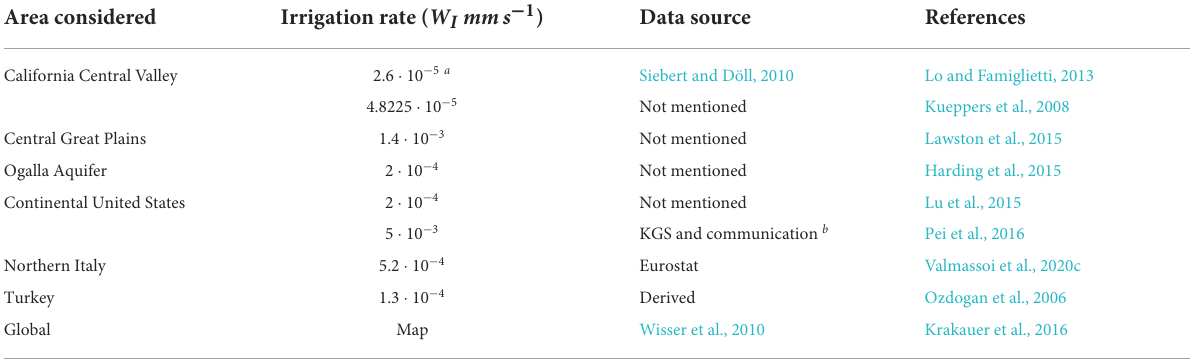
TABLE 2 Table of reported irrigation rates ( W I ) of various studies using an a-priori volume/rate. Area